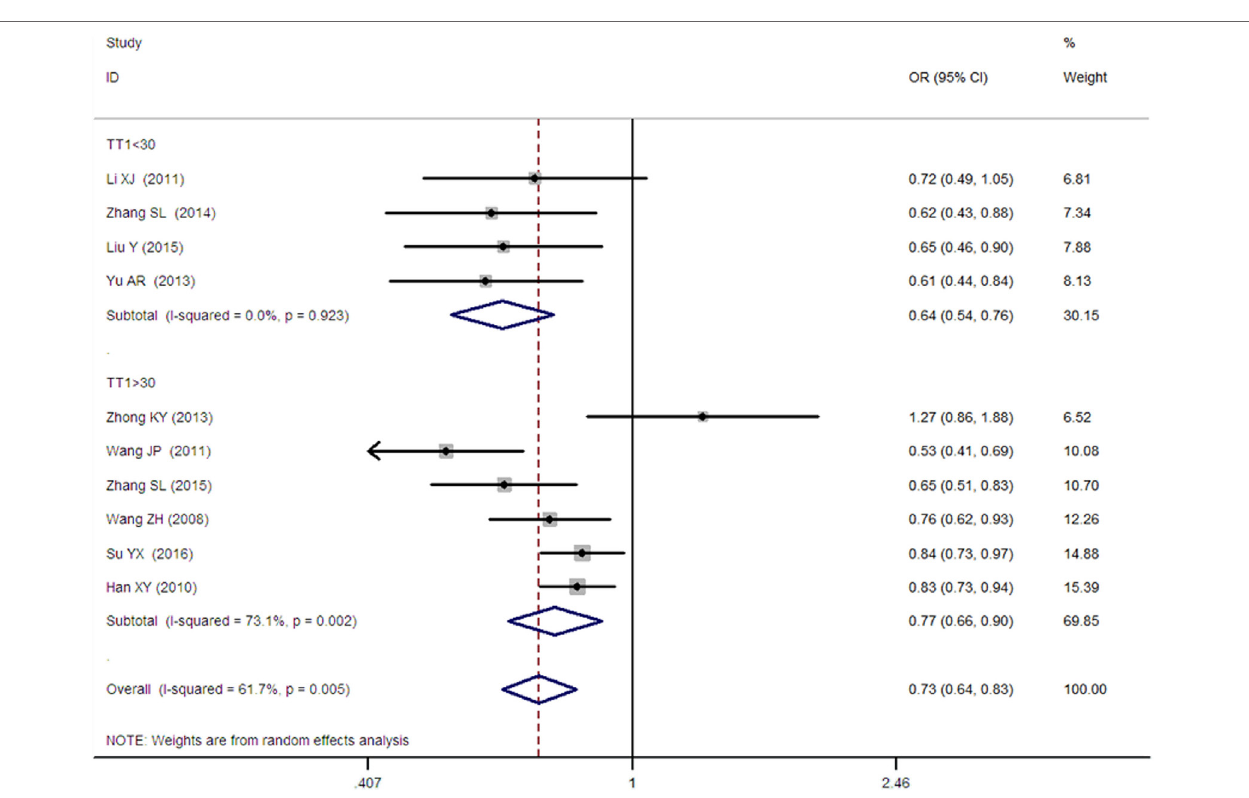
FiGURe 6 | Forest plot of type 2 diabetes mellitus associated with SLC30A8 gene rs13266634C/T in the Chinese population under an additive genetic model (T vs.